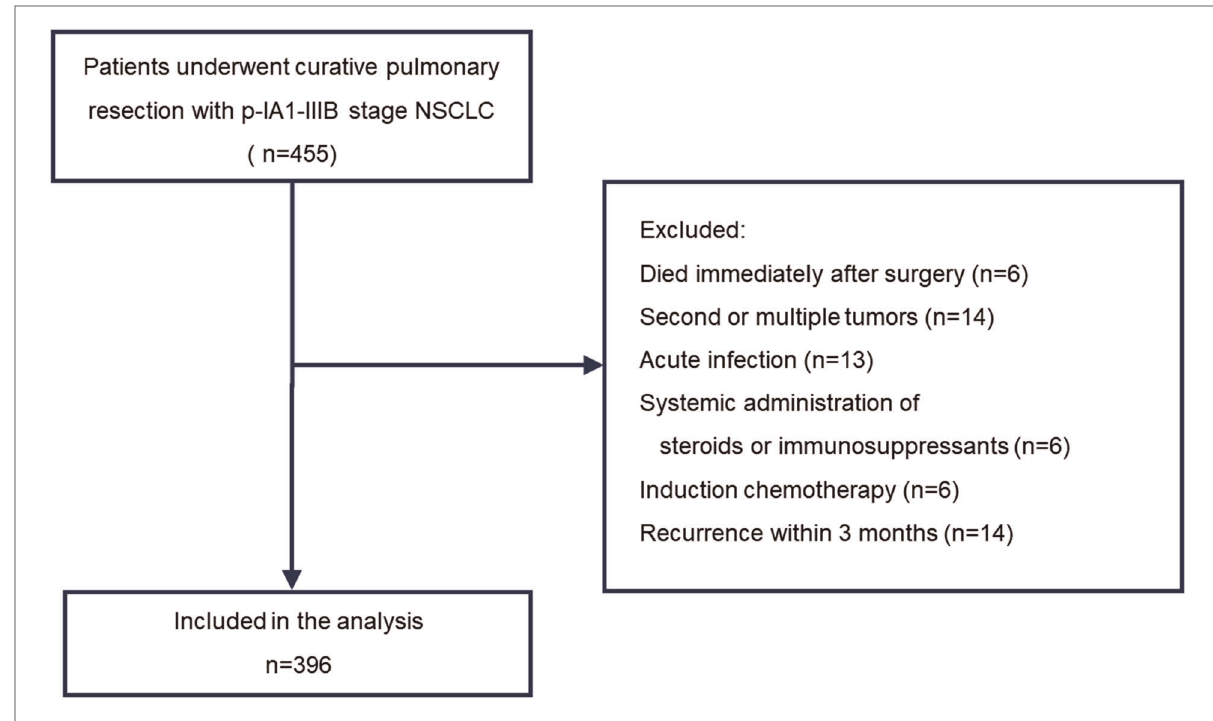
FIGURE 1 Flowchart detailing the selection of patients included in the